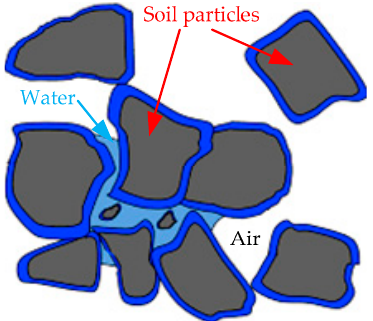
Figure 4. The main soil components.